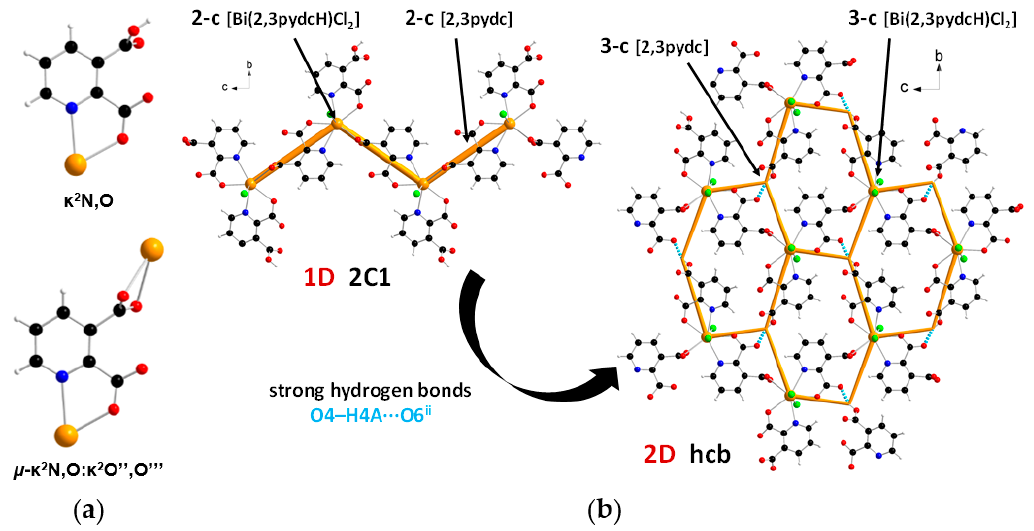
Figure 5. ( a ) Coordination modes of carboxylate ligands in complex 2 ; ( b ) a fragment of the 1D crystal structure merged with 2C1 underlying net in valence-bonded MOFs standard representation and a fragment of the 2D crystal structure merged with hcb underlying the net in H-bonded MOFs standard representation for coordination polymer 2 (Bi—orange, O—red, N—blue, Cl—green, C—black, H— white).